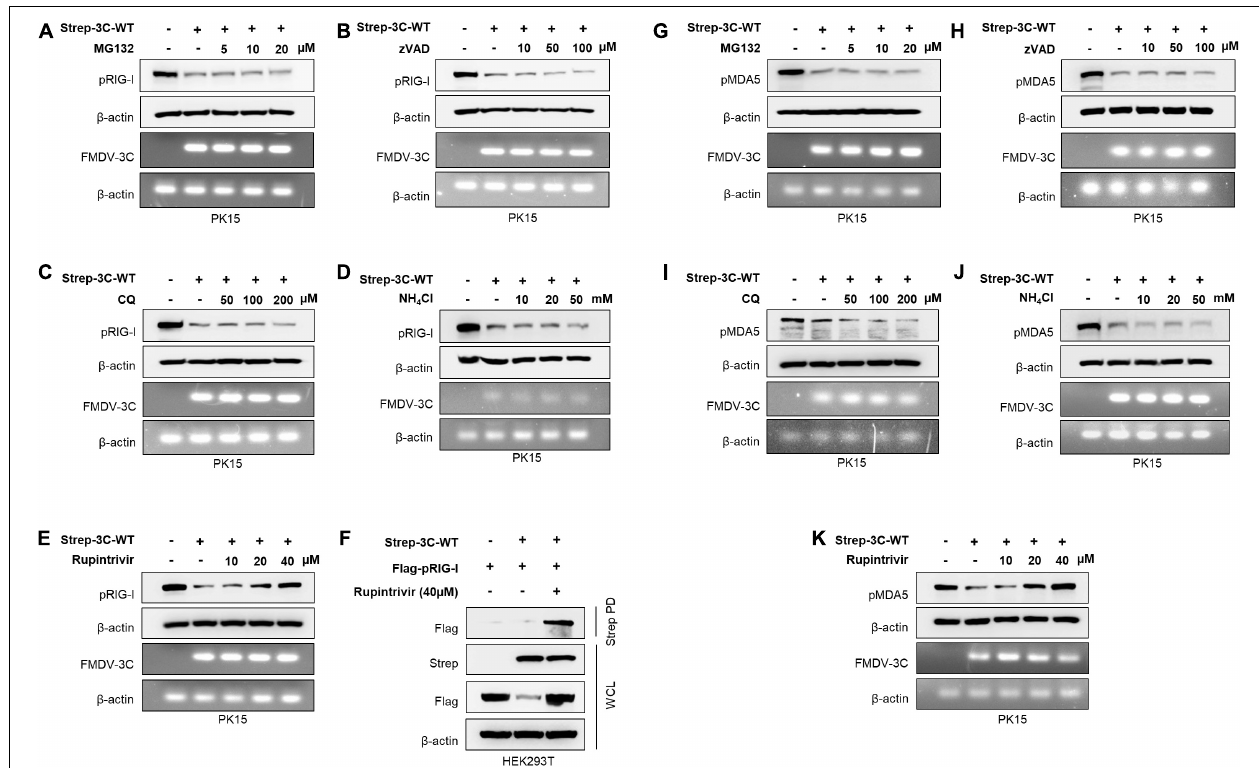
FIGURE 2 | Wild-type FMDV 3C pro degrades RIG-I and MDA5. PK15 cells were transiently transfected with control plasmid or wild-type FMDV 3C pro in the absence or presence of (A) MG132 (5, 10, 20 µ M), (B) Z-VAD (10, 50, 100 µ M), (C) CQ (50, 100, 200 µ M), (D) NH 4 Cl (10, 20, 50 mM), and (E) Rupintrivir (10, 20, 40 µ M). Cell lysate was subjected to immunoblotting with antibody against RIG-I and β -actin, following the qRT-PCR for FMDV 3C pro and β -actin. (F) HEK293T cells were cotransfected with the Flag-tagged porcine RIG-I plasmid together with control plasmid or Strep-tagged FMDV 3C pro plasmid in the absence or presence of Rupintrivir. The cell lysate was subjected to Strep pulldown followed by immunoblotting with individual antibodies against Flag, Strep, or β -actin. (G–K) PK15 cells were transfected with control plasmid or wild-type FMDV 3C pro following the EV71 infection in the absence or presence of (G) MG132 (5, 10, 20 µ M), (H) Z-VAD (10, 50, 100 µ M), (I) CQ (50, 100, 200 µ M), (J) NH 4 Cl (10, 20, 50 mM), and (K) Rupintrivir (10, 20, 40 µ M) as indicated above. Cell lysates were subjected to immunoblotting against individual antibodies of MDA5 and β -actin, following the qRT-PCR for FMDV 3C pro and β -actin. FMDV, foot-and-mouth disease virus; EV71, enterovirus 71; RIG-I, retinoic acid-inducible gene I; MDA5, melanoma differentiation-associated protein 5; qRT-PCR, real-time quantitative reverse transcription PCR. All the data are representative of two independent experiments, each with similar